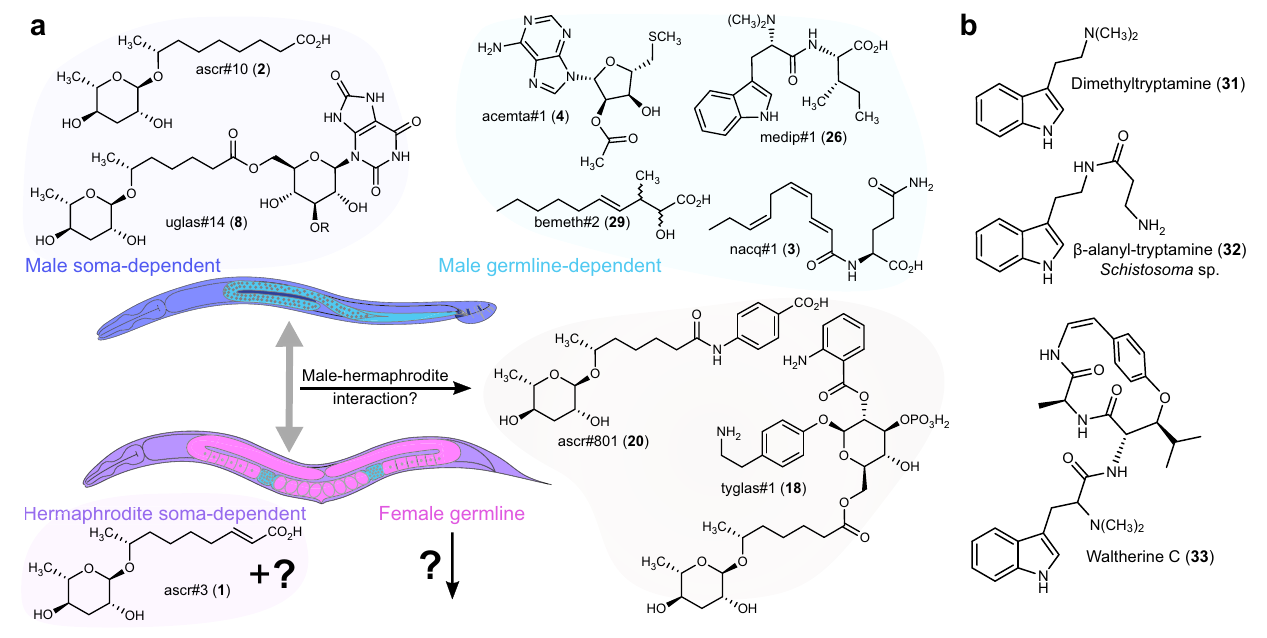
Fig. 5 | Tissue-speci fi c origin of sex-speci fi c metabolites and related com- pounds from other natural sources. a Soma- and germline dependence of selectedmale-andhermaphrodite-enrichedmetabolites.Reprintedfromref. 61 with